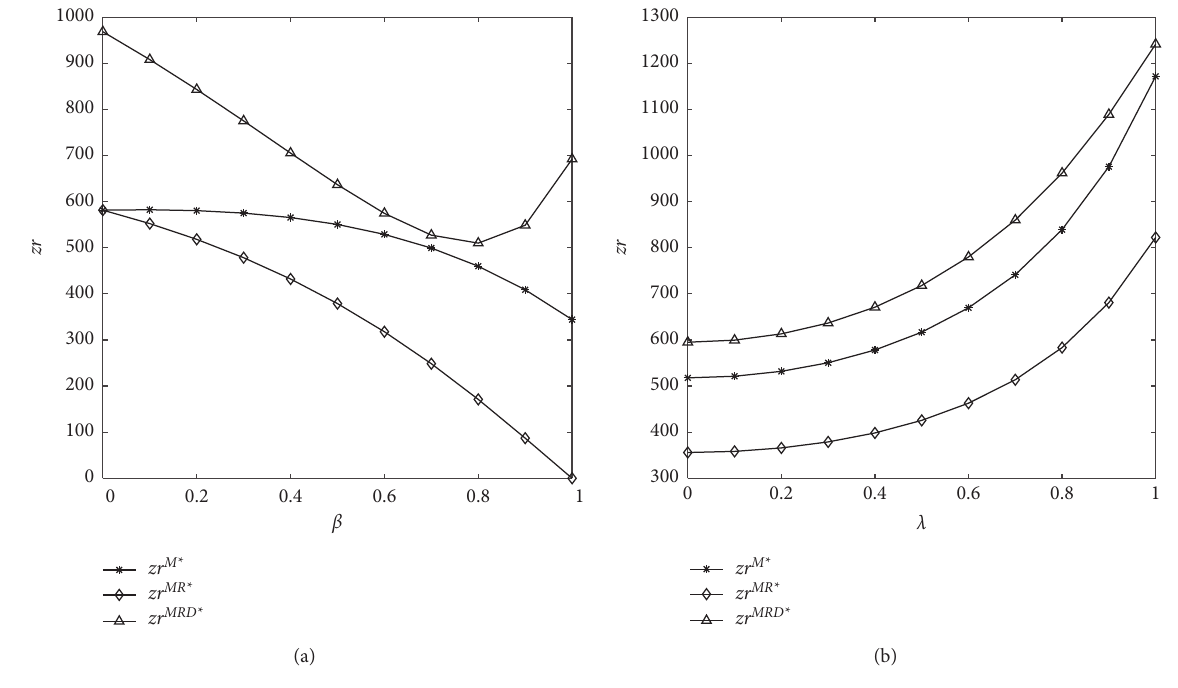
Figure 5: The effect of β and λ on the retailer’s profit.